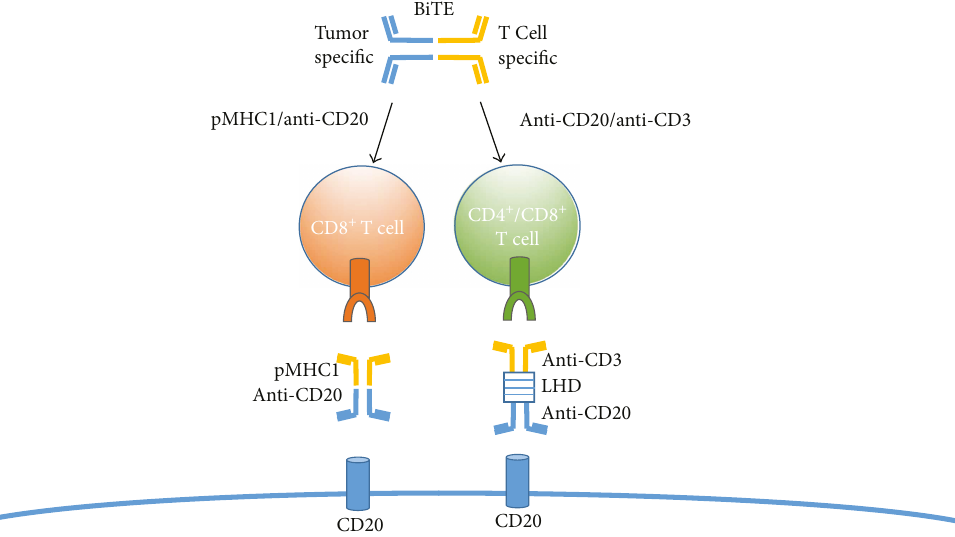
Figure 4: A general schematic outlining the structure of bivalent T cell engager (BiTE) antibodies. One end of the bispeci fi c antibody is against a B cell tumor antigen (CD20), and the other end is speci fi c against T cells (pMHC1 or CD3). The bivalent antibodies help direct T cells toward the vicinity of the tumor to aid in cytotoxic destruction of the